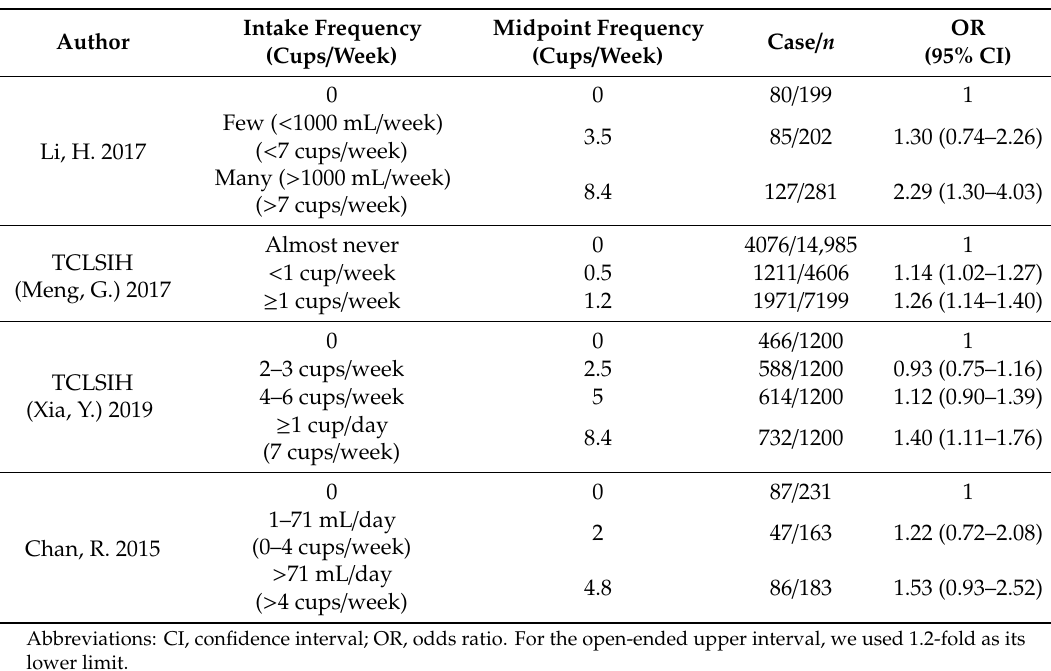
Table 3. Epidemiological studies of the intake frequency of sugar-sweetened beverages (cups / week) and risk of NAFLD.